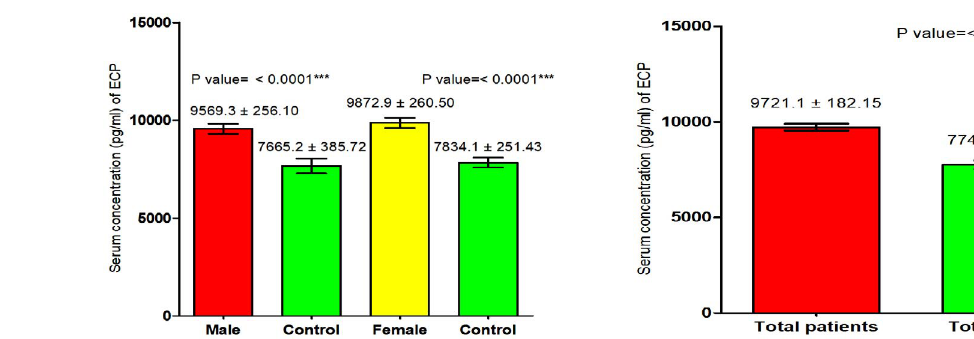
Fig. 1. Comparison between serum level of ECP in patients with Sarcoptes scabiei and control group